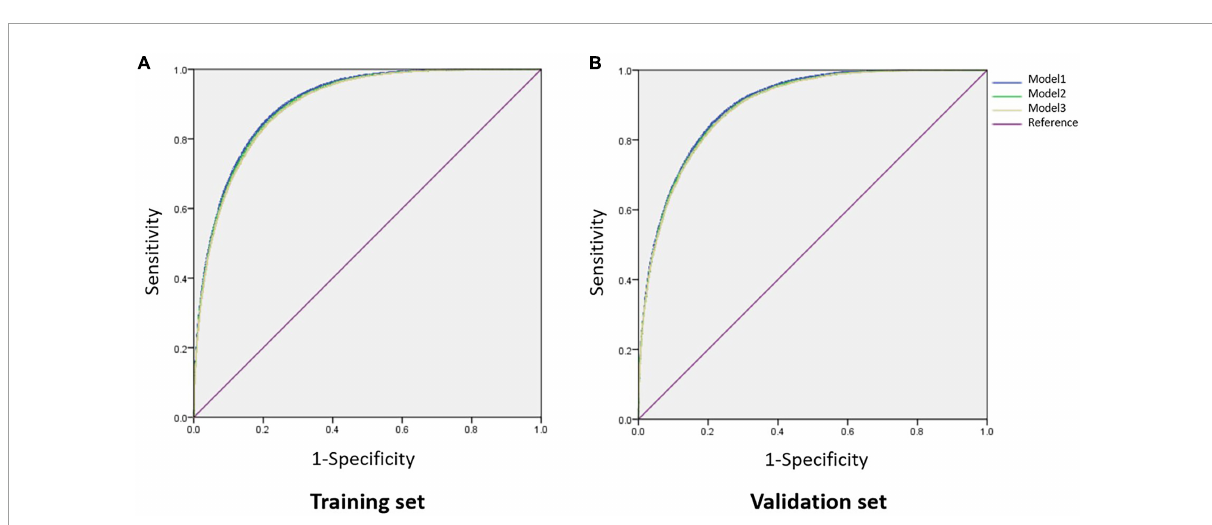
FIGURE3 Comparison of AUCs among different combined models. (A) In the training set; (B) in the validation set. Model 1, BMI, ALT, GGT, TyG, AIP, UA, glucose, age, and DBP; Model 2, BMI, ALT, GGT, TyG, and AIP; Model 3, BMI, AIP, and ALT. AUC, area under the curve; BMI, body mass index; ALT, alanine aminotransferase; GGT, glutamyl transpeptidase; TyG, triglyceride glucose; AIP, atherogenic index of plasma; UA, uric acid; DBP, diastolic blood pressure.